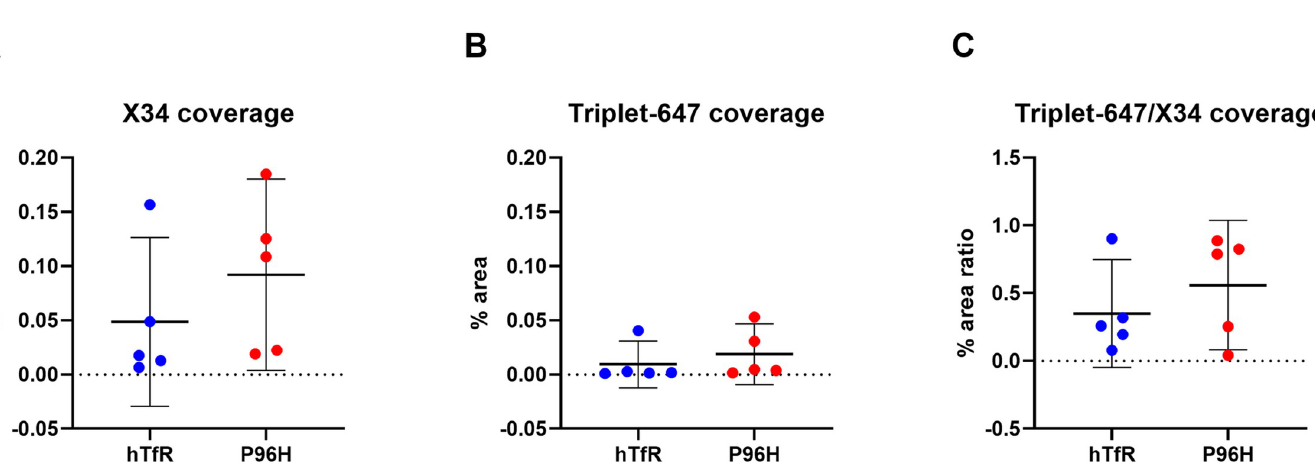
Fig 9. % area and % area ratio of X34 coverage and 647 coverage from mice injected with H1-triplet-647 or M1 P96H -triplet-647. ( A ) The % area of X34 coverage in the X34 channel images. There was no significant difference for mice injected with H1-triplet-647 or M1 P96H -triplet-647; unpaired student t-test, p = 0.3341 ( B ) The % area of Triplet-647 coverage in 647 channel images. There was no significant difference for mice injected with H1-triplet-647 or M1 P96H -triplet-647; unpaired student t-test, p = 0.4815. ( C ) The % area ratio of Triplet-647/X34 coverage. There was no significant difference for mice injected with H1-triplet-647 or M1 P96H -triplet-647; unpaired student t-test, p =